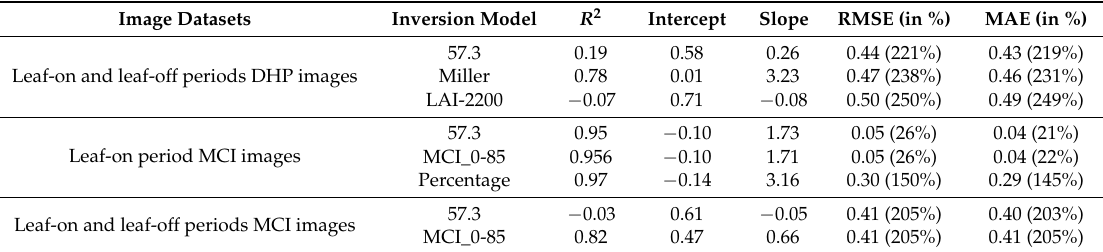
Table 6. Correlation statistics between the α e estimated from DHP and MCI and the reference α of the five plots. Statistics are given at the 95% confidence level from the two-tailed Student’s t -test. Image